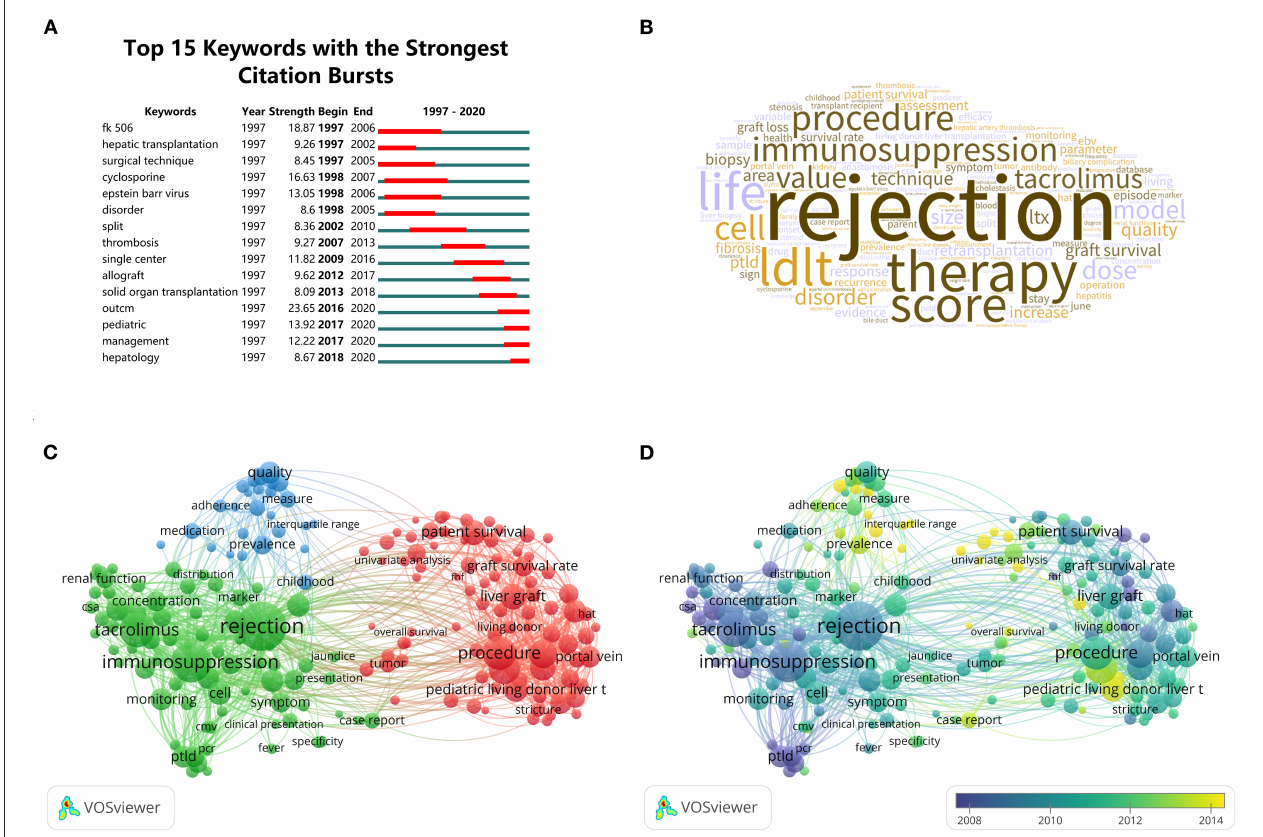
FIGURE 3 | Hotspots in pediatric liver transplantation (PLT). (A) Top 15 keywords with the strongest citation bursts. (B) Word cloud of terms of PLT. The sizes of the words are proportional to their occurrence times. (C,D) Term co-occurrence network created by VOSviewer. (C) is the network visualization, and (D) is the overlay visualization. The resolution in the action panel is set at 0.85. The weight in the options panel is set as “total link strength.” Circle size means the occurrence times of the terms. In (C) , circles are colored according to their clusters. In (D) , circles are colored differently according to their average occurrence